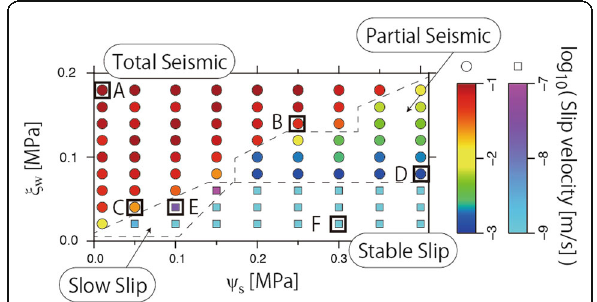
Fig. 4 Phase diagram for different types of slip behavior. Color intensity represents slip velocity. Symbols (circles and squares) denote the color scale used. The six parameter sets shown as examples in Figs. 2 and 3 are indicated by text labels A –